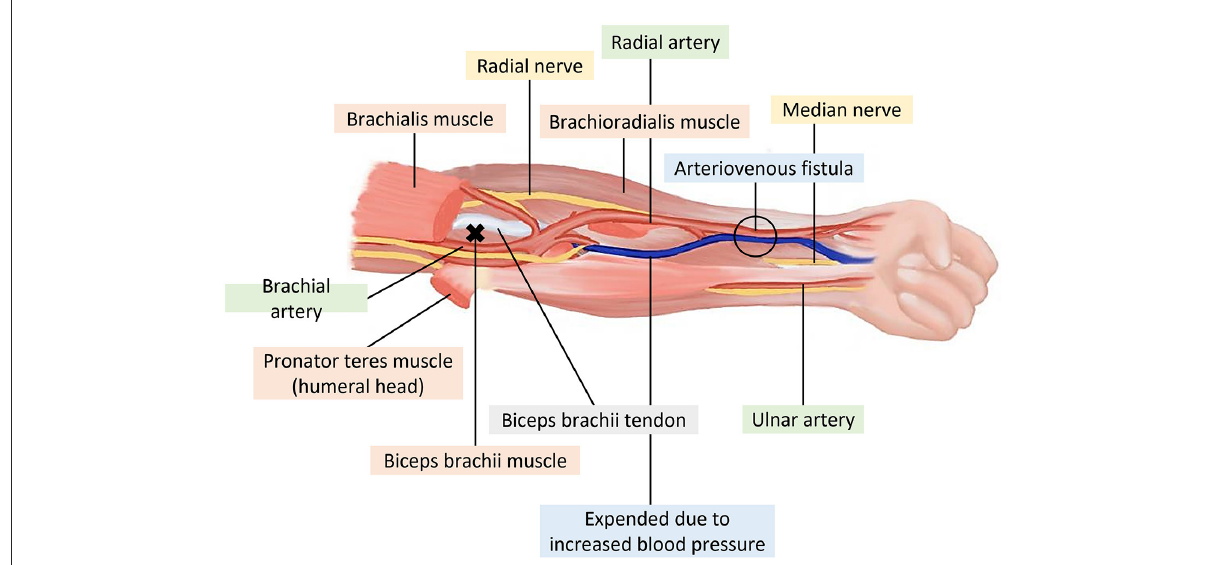
FIGURE2 Muscles of the anterior forearm around the arteriovenous fistula (x: trigger points of the biceps